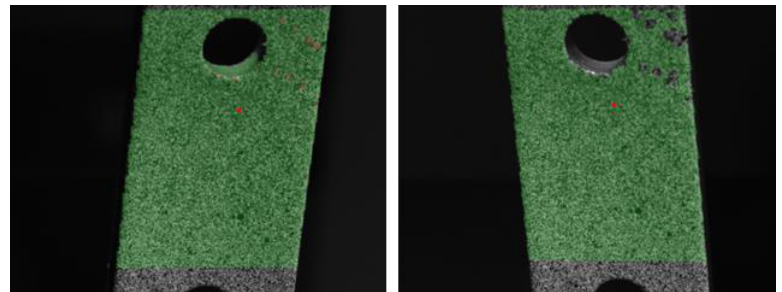
Figure 6. Recorded field, left and right camera.